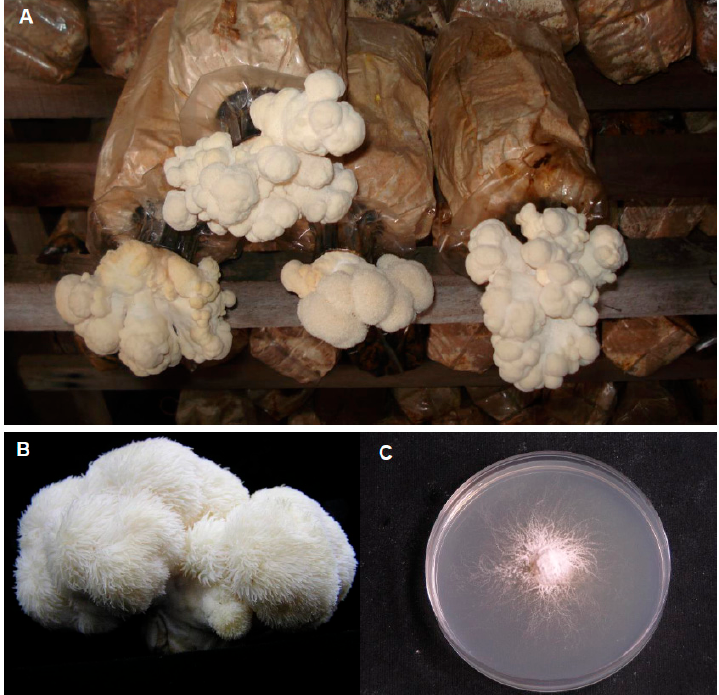
Figure 1. Fruiting bodies cultivated at the tropical climate in Malaysia ( A , B ) and mycelia ( C ) of Hericium erinaceus grown on potato dextrose agar.